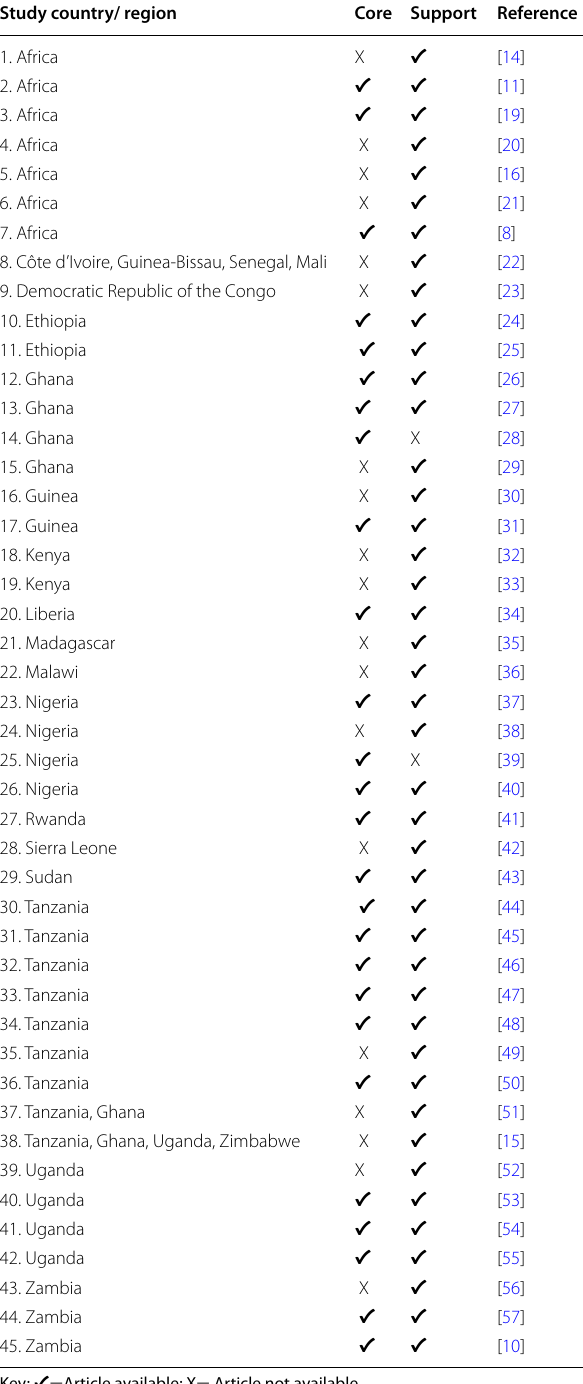
Table 2 Articles on IDSR core and support functions in Sub- Saharan